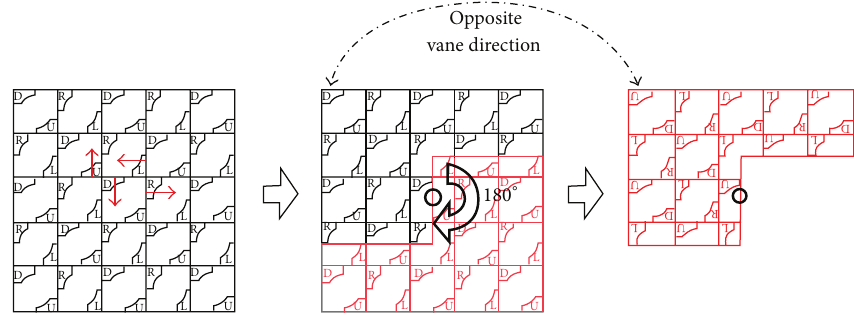
Figure 6: Geometrical simplified model of the grid strap.